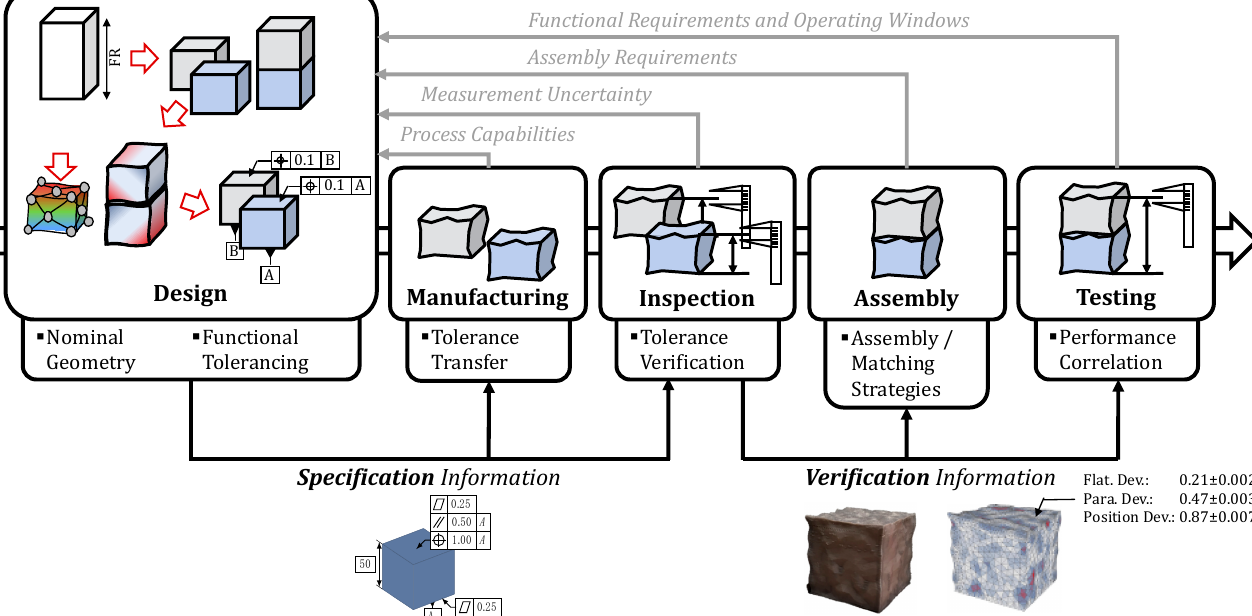
Figure 1. The ubiquitous role of tolerances and different types of tolerancing information. FR: functional (customer) requirements.